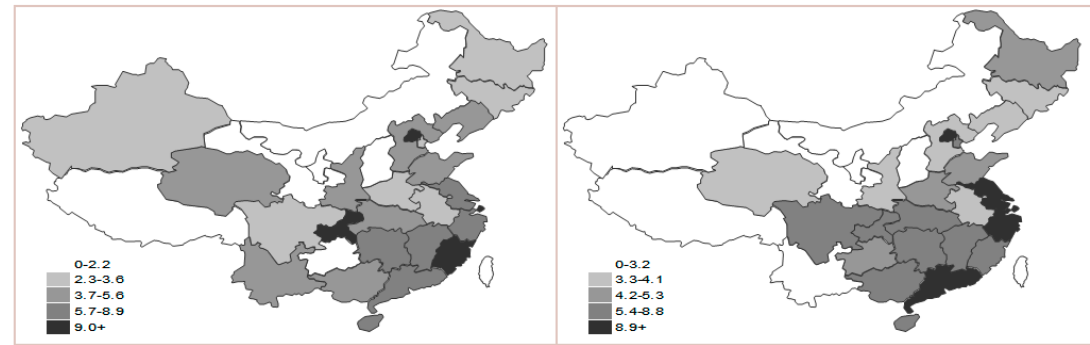
Figure 7. Map of state sub-index in 2000 and 2015.